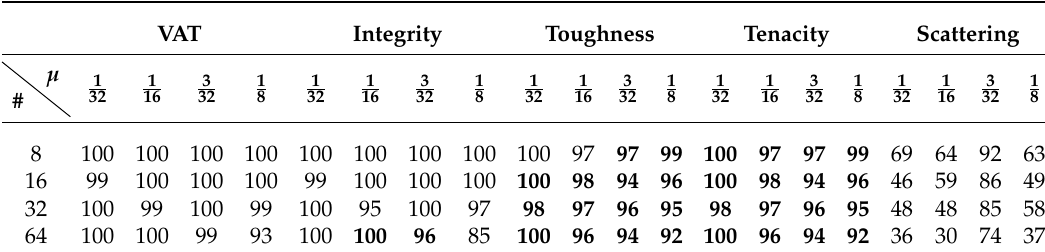
Table 2. Percent accuracy for NBR–Clust on Girvan–Newman graphs for varying mixing factors µ . Bold text indicates one-step clustering.